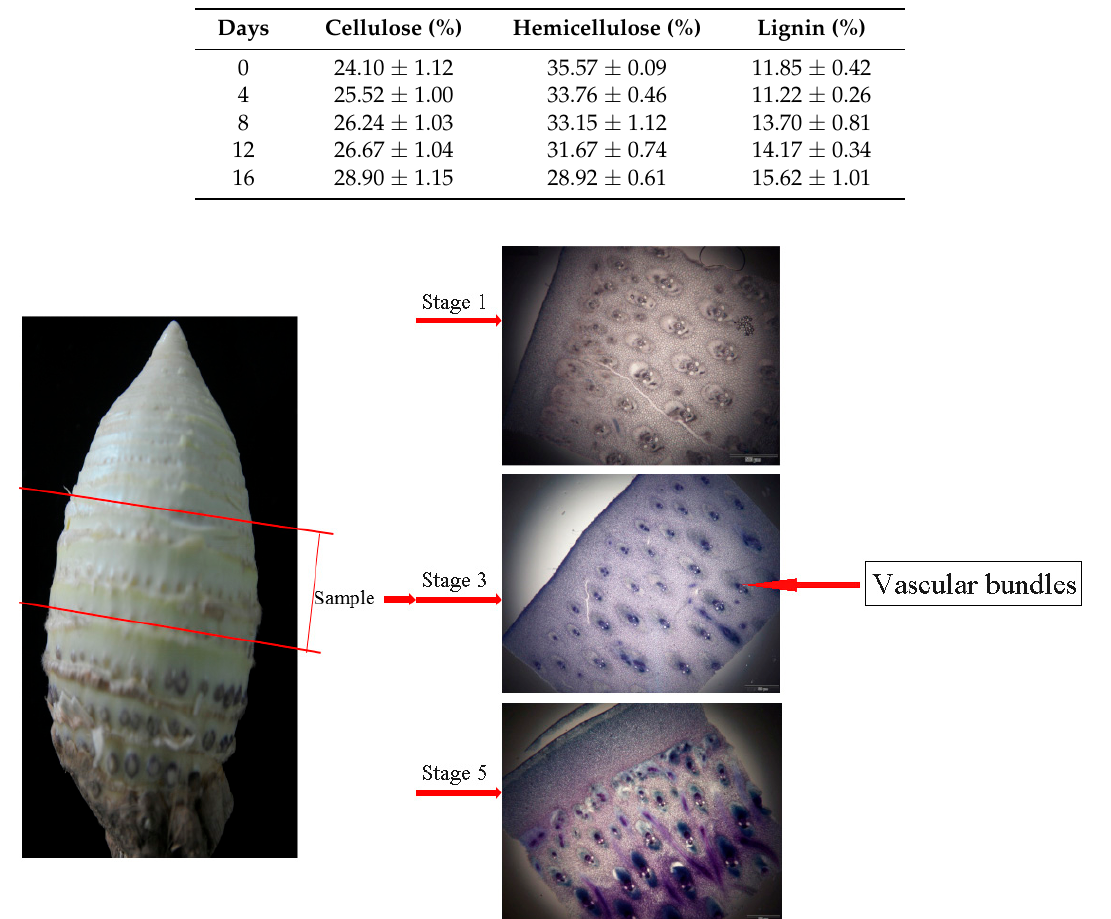
Table 1. Chemical composition of Moso bamboo shoots (MBSes) during storage at 4 °C. Data were average values ± SE ( n = 3). Different letters indicate significant differences between diverse storage times ( P < 0.05).